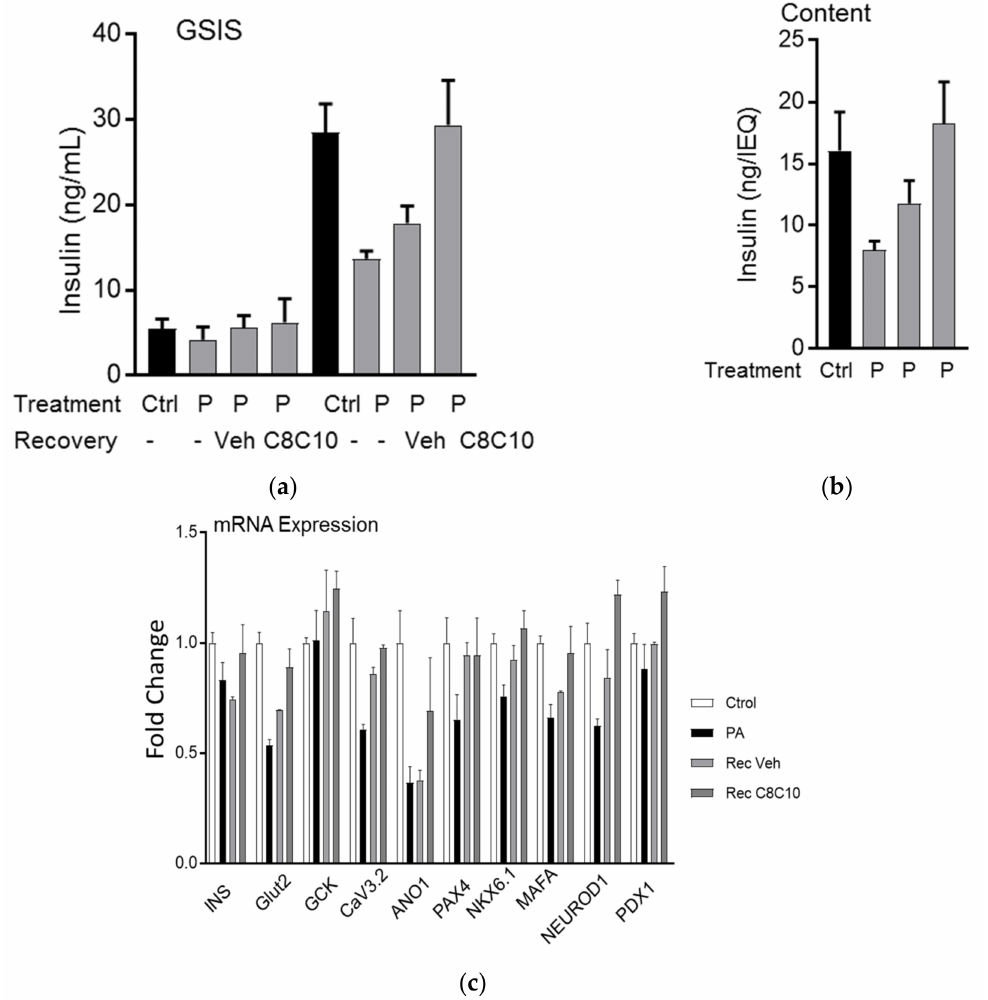
Figure 6. Chronic MCFA treatment improves β -cell function in human islets. ( a ) Glucose stimulated insulin secretion (GSIS) and ( b ) insulin content in healthy human islets treated with palmitate (P, 0.5 mM for 72 h) followed by recovery in the presence or absence of the medium chain fatty acid mixture, C8:C10 40:60. ( c ) Fold change of selected genes in human islets treated as above, using a NanoString n-counter gene expression